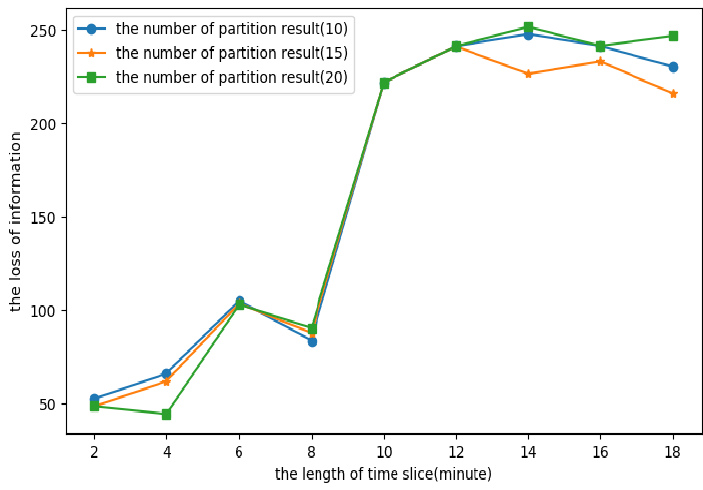
Figure 12. The loss of information (Geolife dataset).